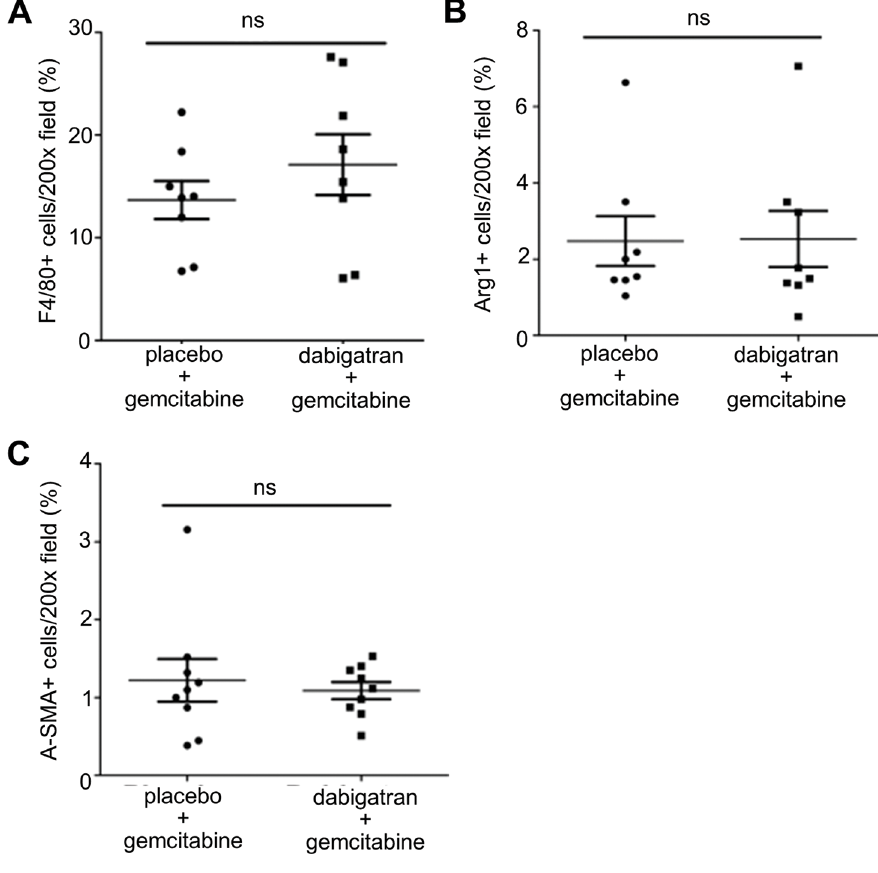
Figure 5. Effect of dabigatran on macrophage recruitment and fibroblast activation in pancreatic cancers of gemcitabine-treated mice. Quantifications of sections obtained from tumors of gemcitabine- or gemcitabine/dabigatran-treated mice stained for (A) F4/80, (B) Arg-1 and (C) a-SMA. NS = not